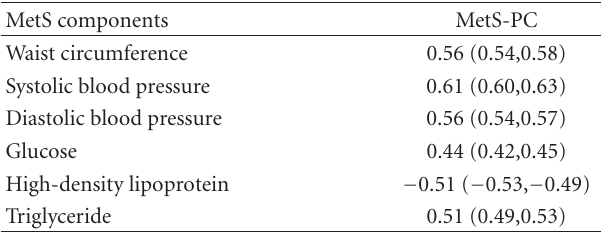
Table 2: The correlation between the original elements of metabolic syndrome and MetS-PC (first principal